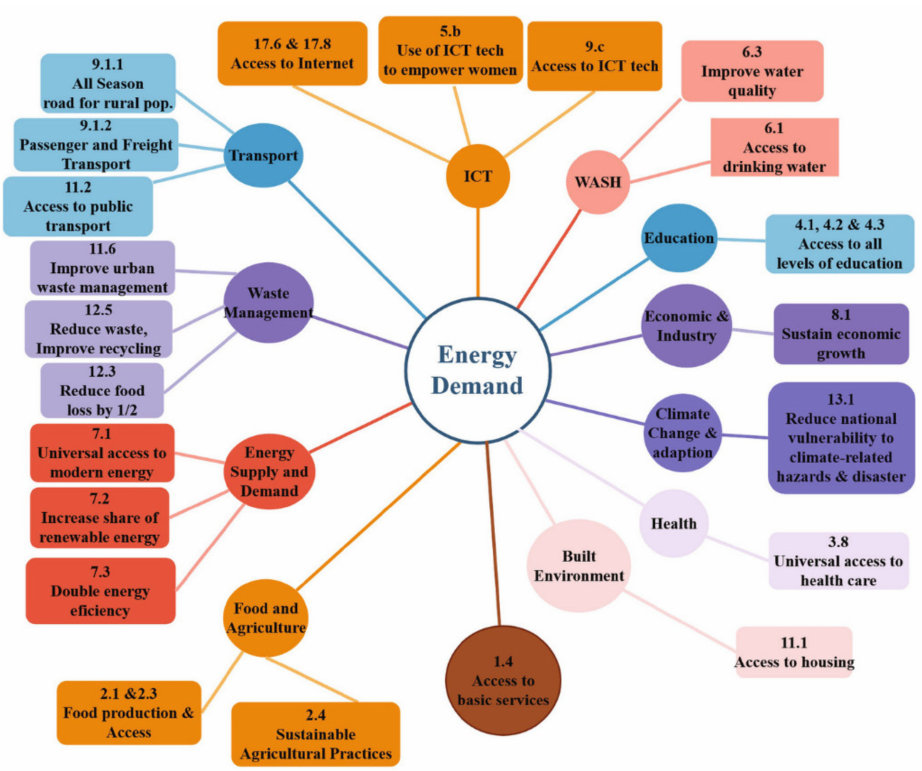
Figure 1. Energy Related SDGs at Tourism Destinations, (https://link.springer.com/chapter/10.100 7/978-3-030-35291-2_6) (12 February